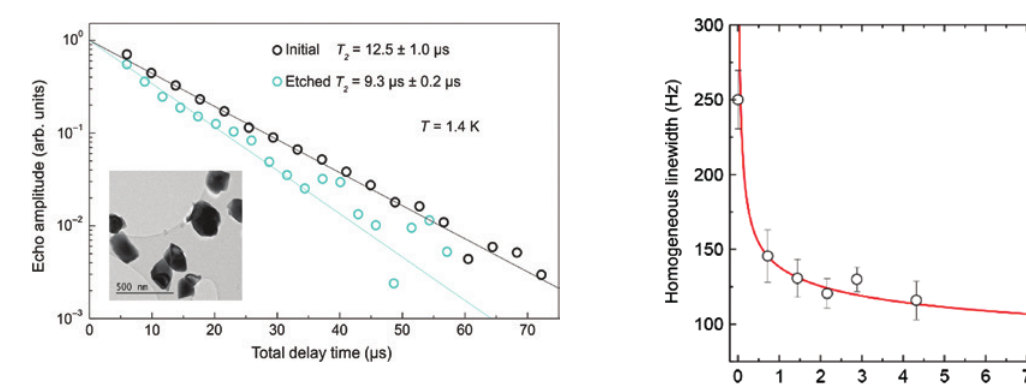
Figure 2: Optical echo decays in Eu 3 + :Y after chemical etching.